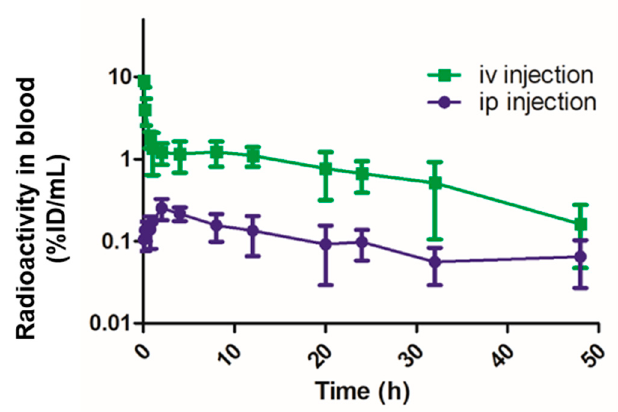
Figure 4. The radioactivity-time profile in blood after intravenous (iv) injection or intraperitoneal (ip) injection of 111 In-Au@HSANPs in CT-26 tumor/ascites mice. After iv or ip injection of 111 In-Au@HSANPs, blood from the tail vein was sampled by 1- µ L capillary at designated time points and the radioactivity of each sample was counted using a gamma counter. Each value is expressed as a percentage of injected dose per milliliter (%ID/mL) and represents the mean ± SD ( n = 5).